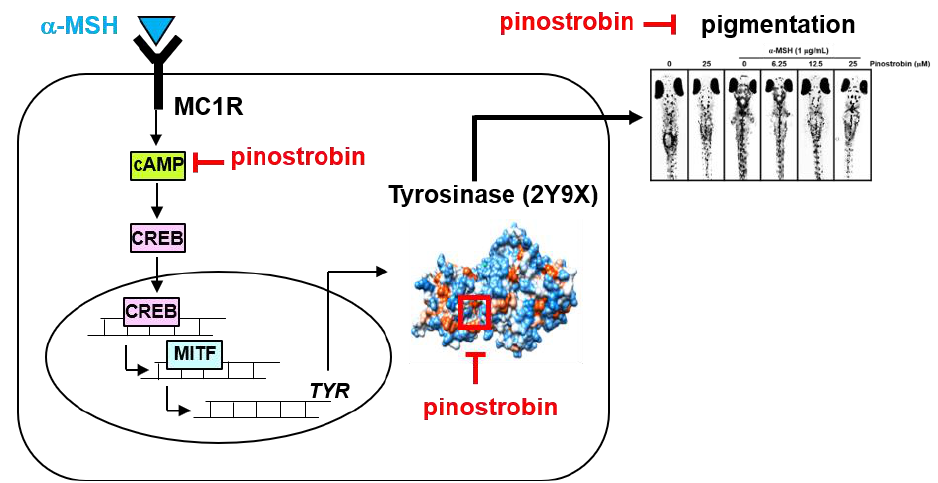
Figure 7. A scheme showing the molecular action of pinostrobin in inhibiting melanogenesis.